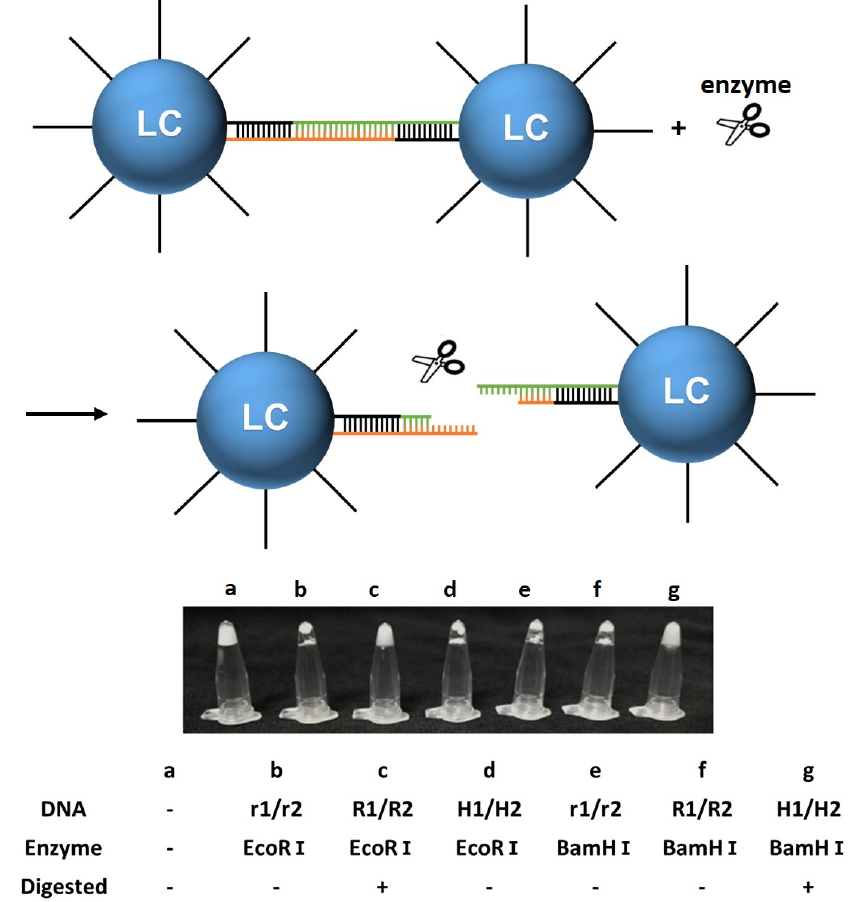
Figure 6. Schematic representation of the responsiveness of LC droplets to enzymes. The photographs of the LC droplets in DNA-C18 with and without enzyme. ( a ) Unmodified LC droplets, ( b ) random1 + random2 + EcoR Ⅰ , ( c ) R1 + R2 + EcoR Ⅰ , ( d ) H1 + H2 + EcoR Ⅰ , ( e ) random1 + random2 + BamH Ⅰ , ( f ) R1 + R2 + BamH Ⅰ , ( g ) H1 + H2 + BamH Ⅰ .